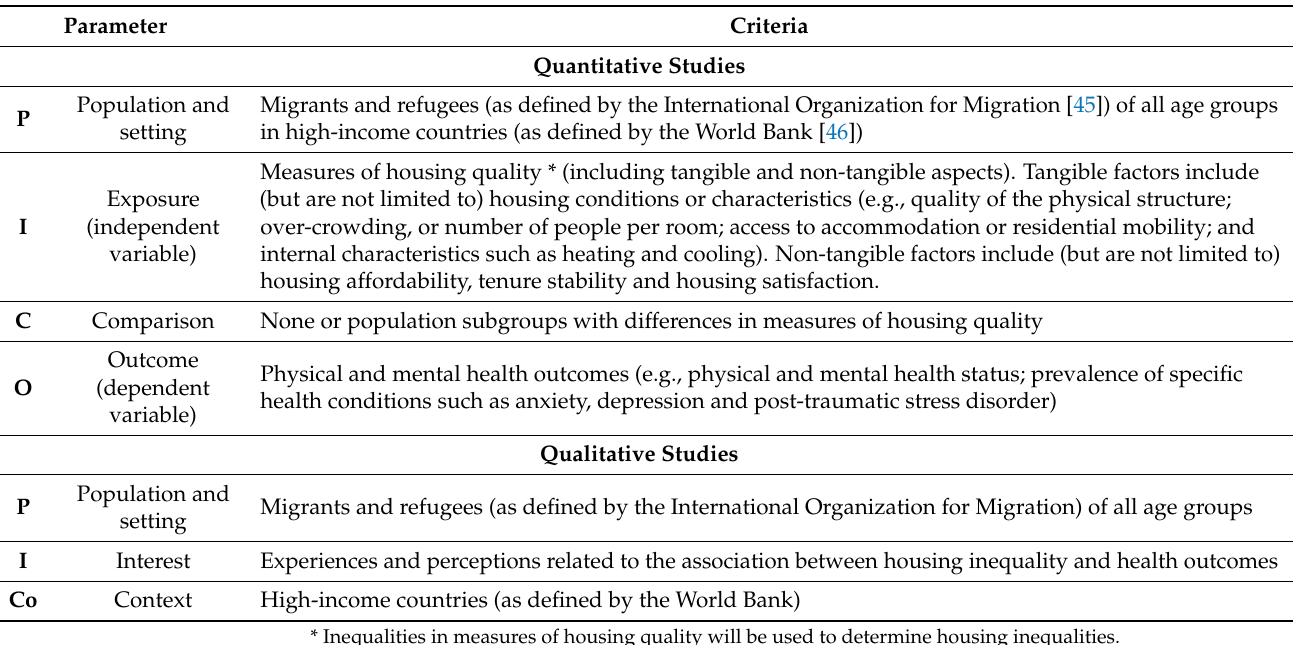
Table 1. Inclusion criteria for quantitative and qualitative